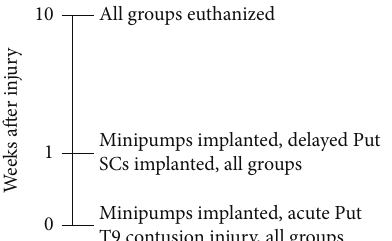
Figure 2: Methodology timeline: all groups received a T9 contusion injury at the 0-week time point. The Acute Put + SC group also received the putrescine-administering minipumps within 30 minutes of injury. At 1 week after injury all groups received SC. Also at 1 week after injury the Delayed Put + SC group received the putrescine-administering minipumps. All groups were euthanized and prepared for tissue processing at 10 weeks after